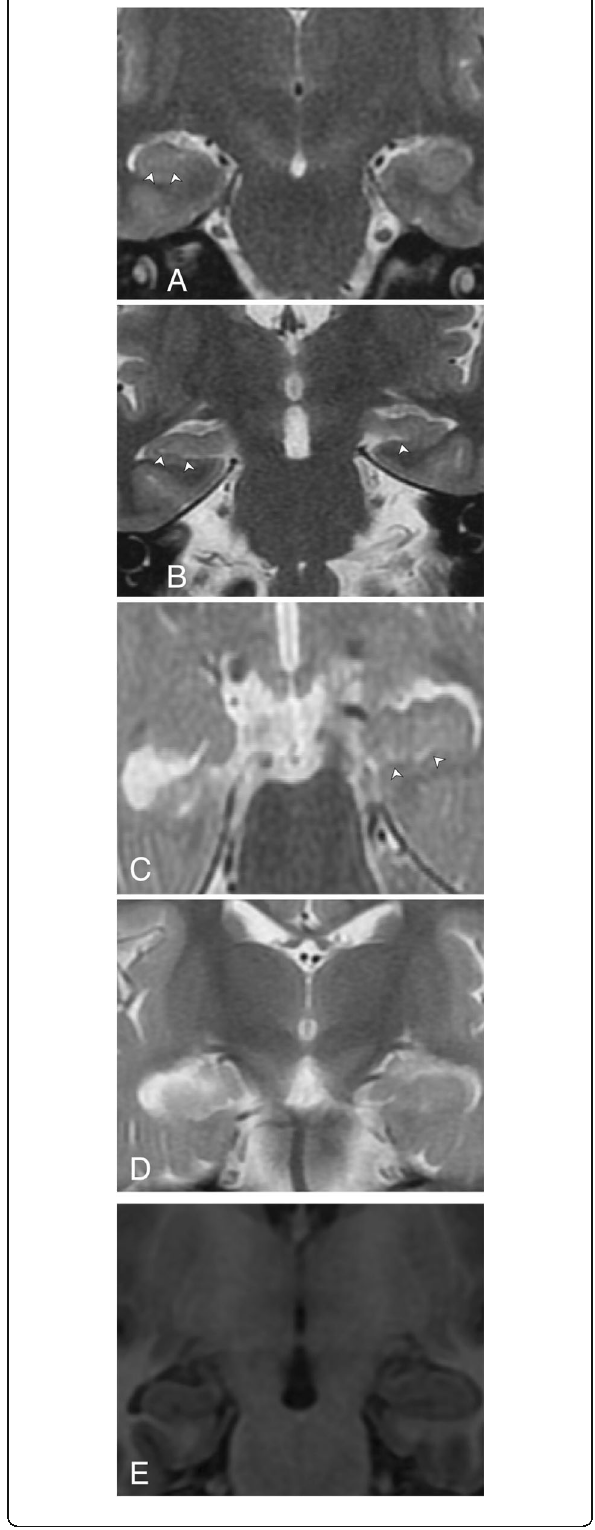
Fig. 2 a – d High-resolution coronal T2-weighted images with magnification; e Coronal SPGR image with magnification. Arrowheads indicate hippocampal striation. a Left PLHS: hippocampal striation (arrowheads) seen better on the right side; not well made out on the left. Cochleae are seen symmetrical on both sides. b Left PLHS: hippocampal striation (arrowheads) seen better on the right side; seen only in medial aspect of the left hippocampus. Semicircular canals are seen symmetrical on both sides. c Right PLHS: hippocampal striation (arrowheads) seen on the left side; not on the right. The right hippocampus is also small, with increased signal intensity. d Bilateral PLHS: hippocampal striation not seen on either side; the right hippocampus is smaller in size. e Bilateral PLHS: small size of right hippocampus is also seen on coronal SPGR